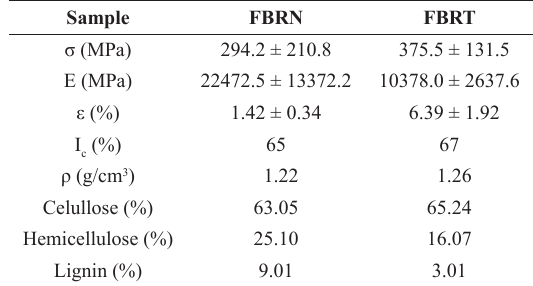
Table 1. Elasticity modulus values, maximum stress, specific deformation, crystallinity index, density and chemical composition for the purple banana